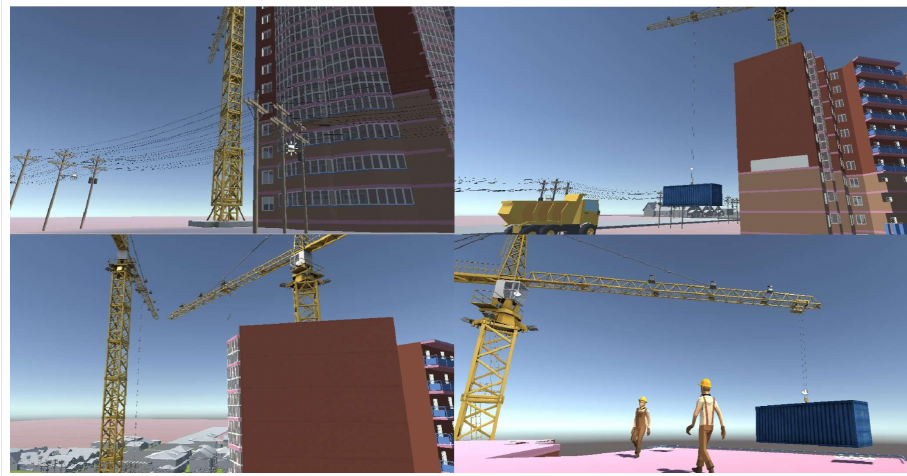
Figure 1. Hazards modeled in